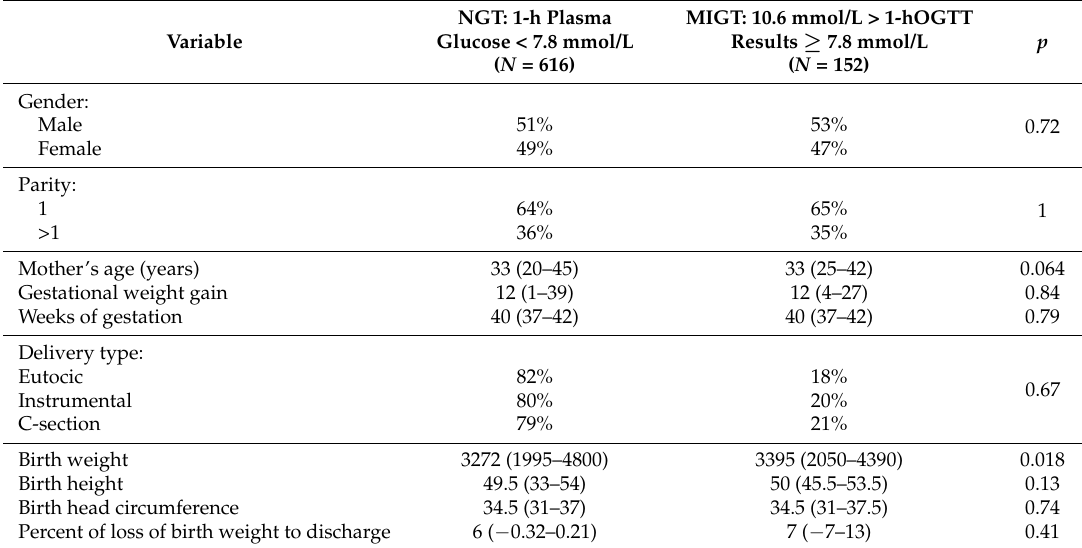
Table 1. Patient